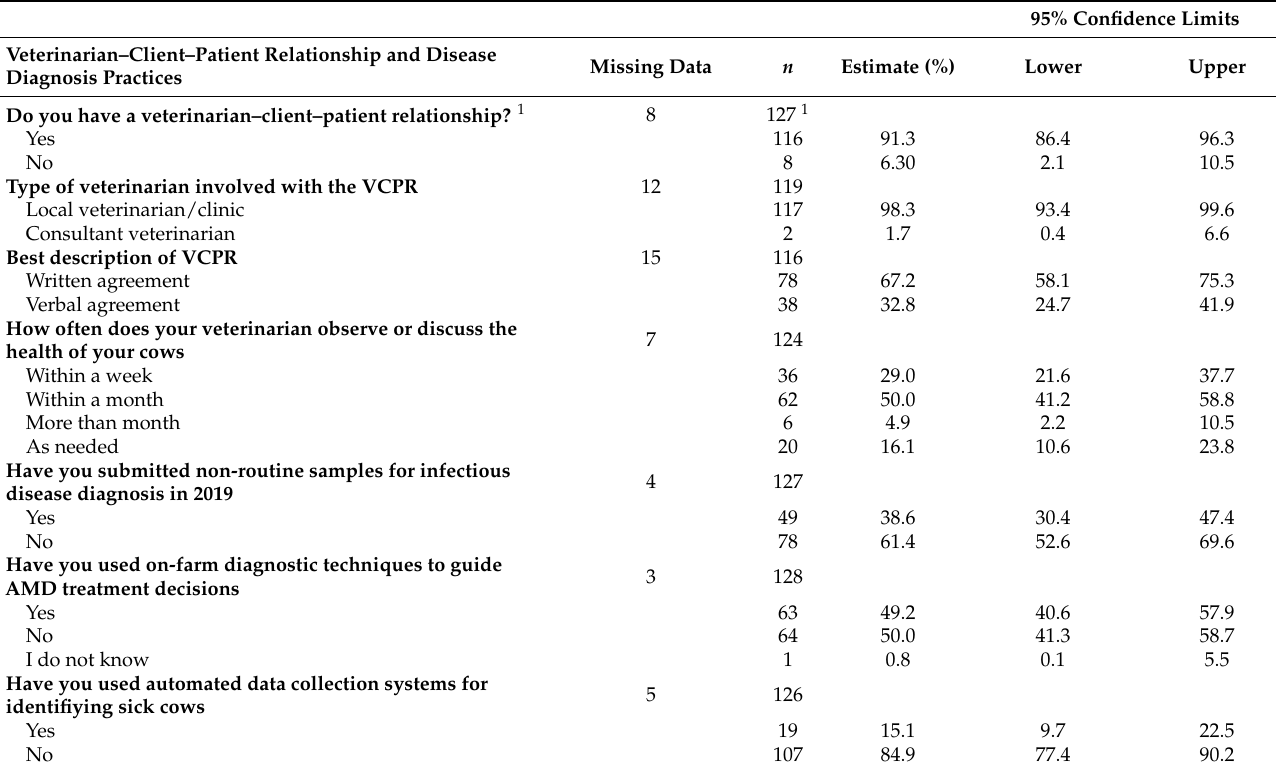
Table 6. Summary of responses to questions about veterinarian–client–patient relationship (VCPR) and disease diagnosis practices, from responses to questionnaire on antimicrobial drug (AMD) use in adult cows on California dairies during